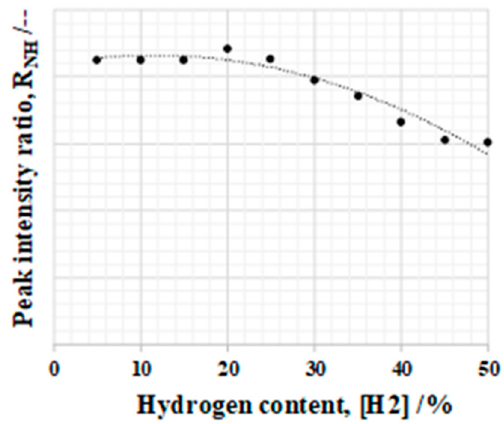
ions with the increase in 2